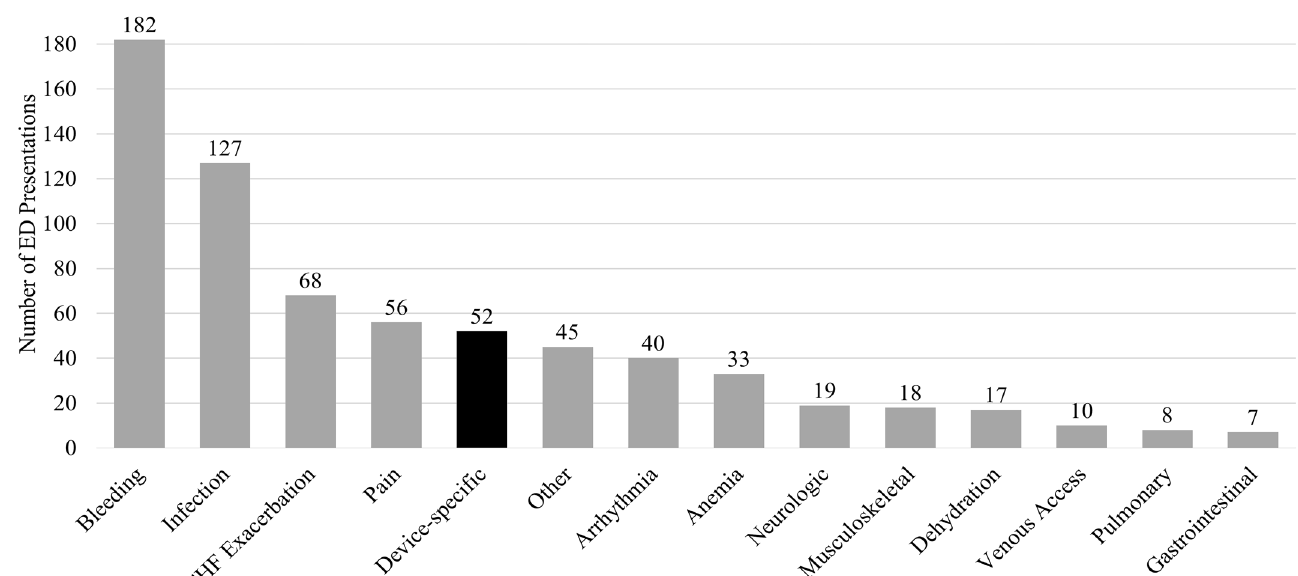
Figure. Number of emergency department (ED) presentations by category from patients with left ventricular assist devices in a five- year period. Device-specific presentations are highlighted in black. CHF , congestive heart failure.